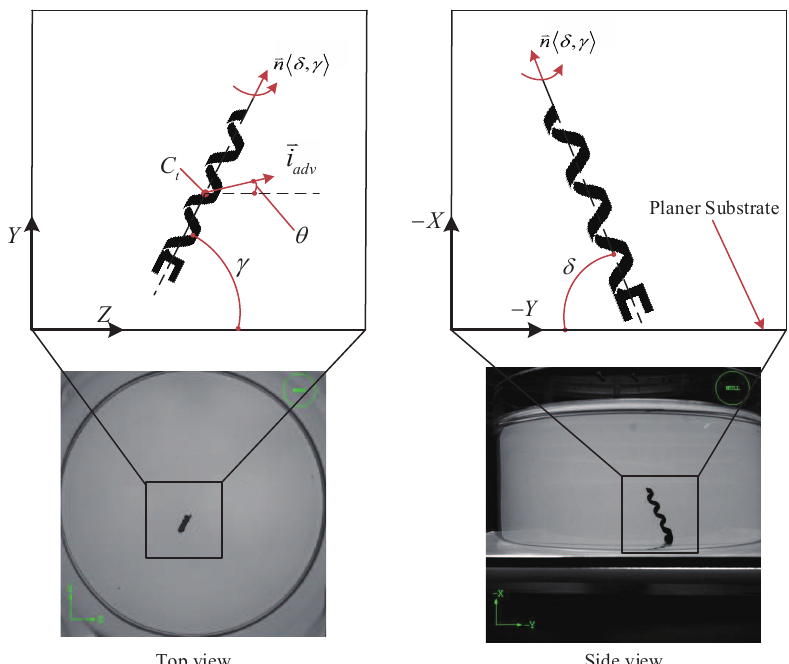
Figure 5. Illustrating the locomotion of helical microswimmers on a planar substrate in top-view and side-view.